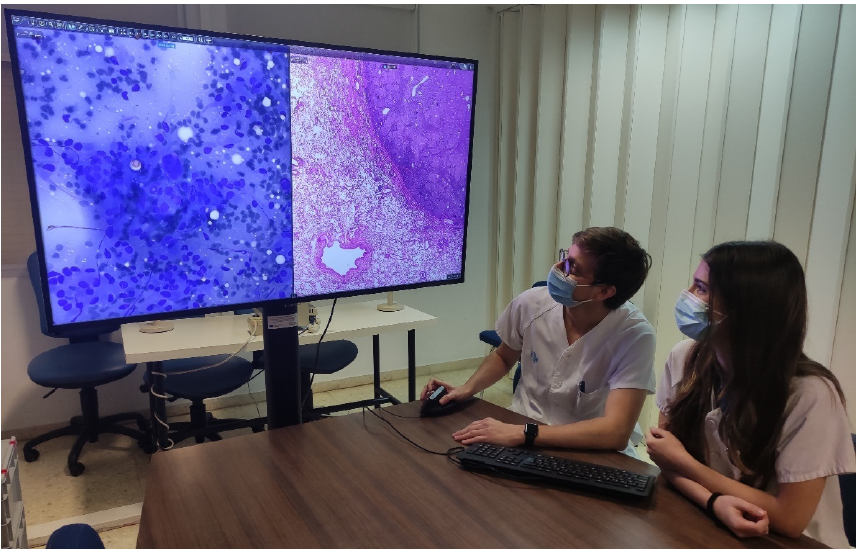
Figure 5. Residents diagnosing using a 55-inch 4K UHD monitor (55UH5F-B). Table 3. Workstation and monitor deployment.